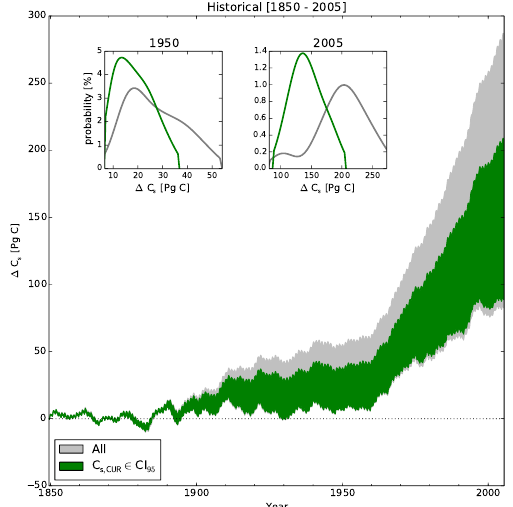
Figure 3. Change in total soil carbon through time for historical simulations. Insets represent the probability density function of the change since 1850 for the period indicated. Grey is for all simula- tions while green is used to distinguish simulations for which to- tal soil carbon is within the CI 95 of the Harmonized World Soil Database in 2005.